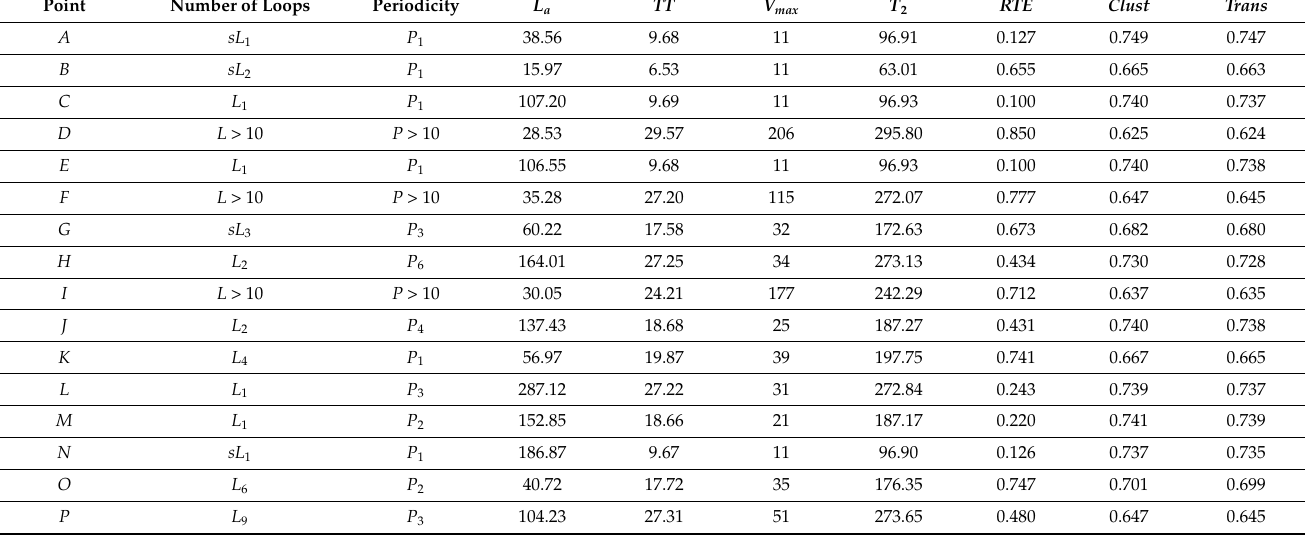
Table 2. The recurrence statistics (RQA) for ε = 0.1. For comparison, in the first two columns, we included information about the number of loops and the main periodicity obtained from the phase portraits and Poincar é points of the mechanical resonator response (see the central panel in Figure 3). P n denotes the period of the solution as the multiple ( n ) of the excitation period, and L n and sL n denote the number ( n ) of large or small loops respectively. The calculations of the RQA parameters were performed in the CRP toolbox for MATLAB [28].